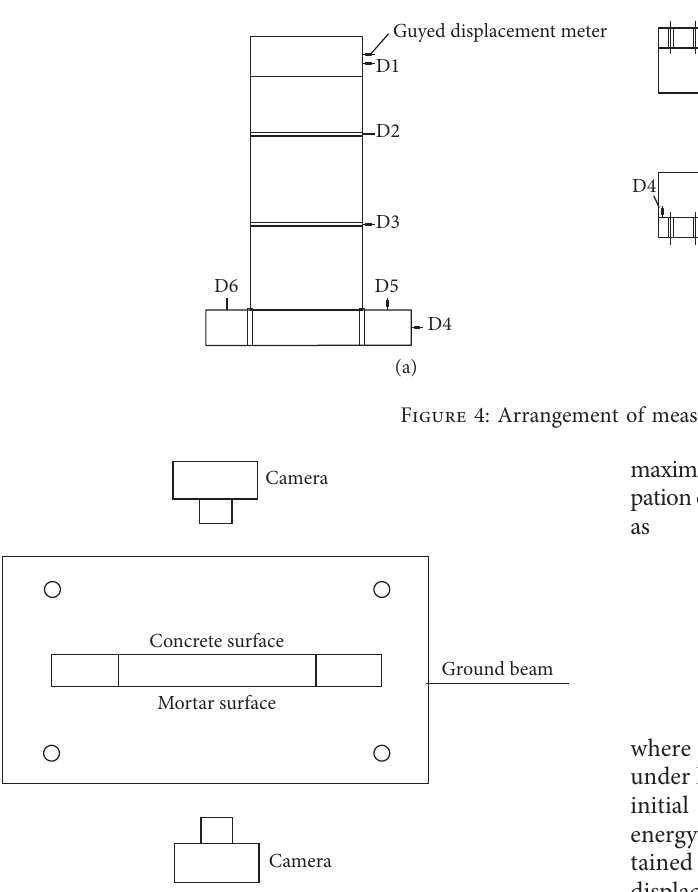
Figure 5: Camera layout of the shear